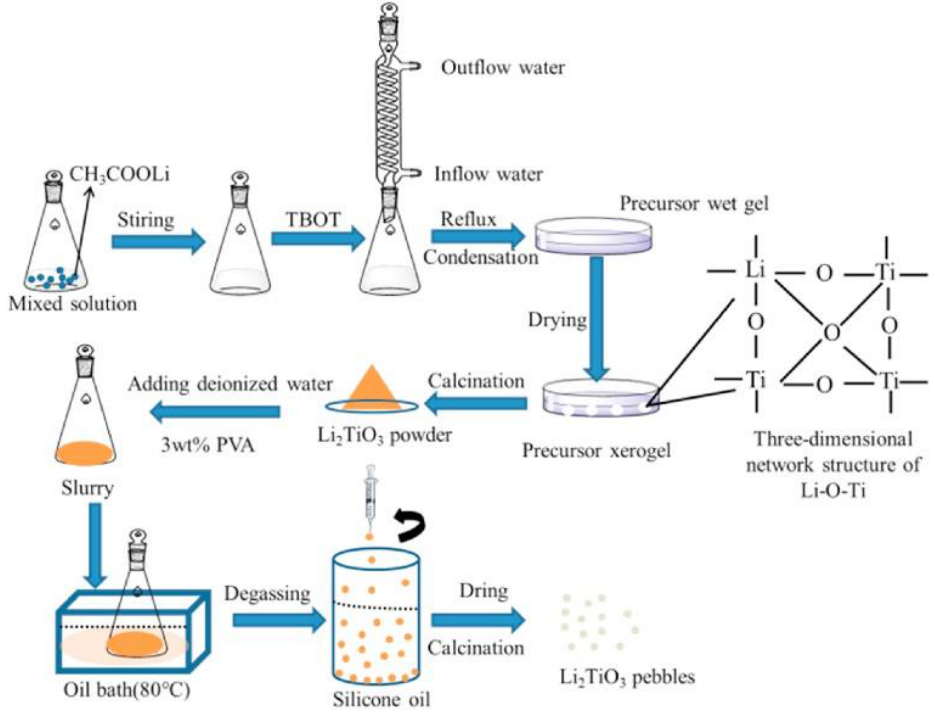
Figure 2. The mechanism figure for the synthesis of Li 2 TiO 3 pebbles by the NHSG method. Reprinted with permission from Ref. [49].